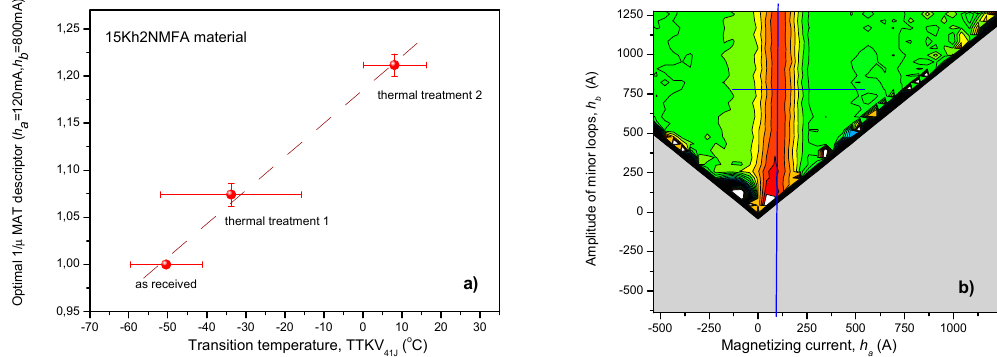
Figure 7. ( a ) Optimally chosen normalized MAT descriptor as a function of transition temperature for 15Kh2NMFA material; ( b ) the corresponding map of sensitivity, which shows the position of this descriptor.